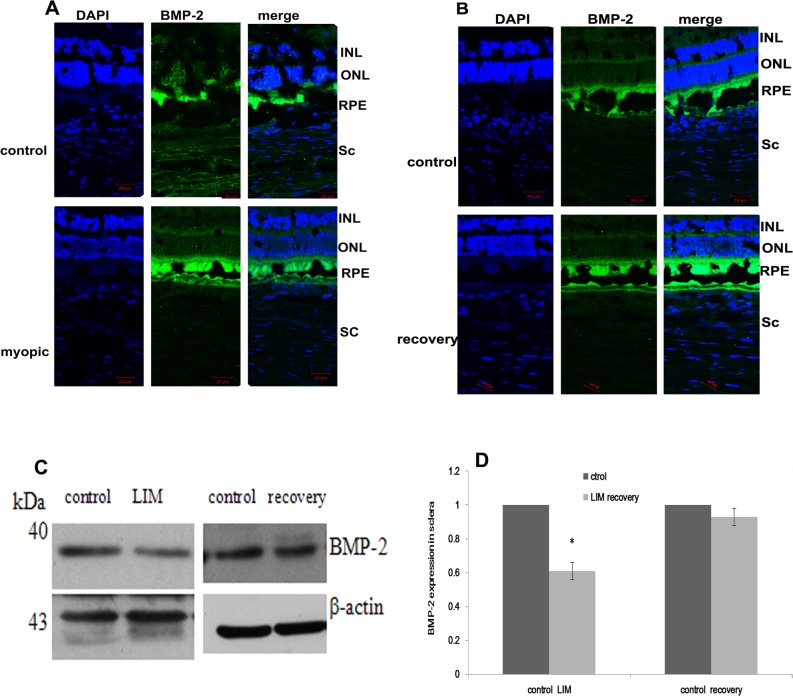
BMP-2 expression in myopia and recovery from myopia of guinea pigs.Immunofluorescence analysis of BMP-2 expression in the retina, RPE, choroid and sclera of guinea pigs. The staining in the myopic sclera of the LIM group was weaker than that of the control eyes (A). Changes in the expression of BMP-2 in the sclera of guinea pigs detected by western blot analysis (C,D). The data are expressed as the mean±SEM, * p≤0.05 vs. the contralateral eye. INL inner nuclear layer, ONL outer nuclear layer, RPE retinal pigmental epithelium, chl choroid, Sc sclera layer.